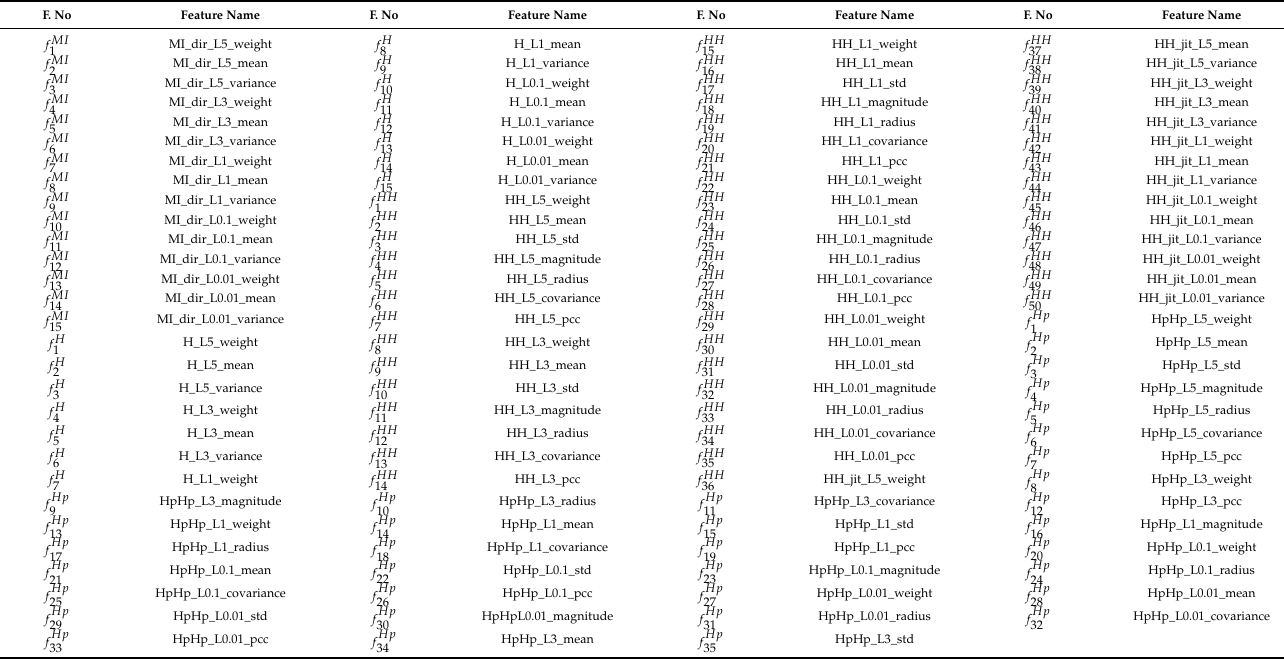
Table A1. The full names of features in the N-BaIoT dataset.